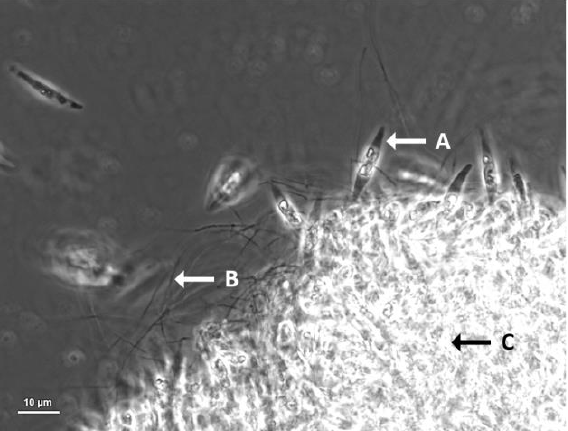
Figure 5. Saccharopolyspora sp. NFXS83 co-cultured with Phaeodactylum tricornutum CCAP 1055/1, 10 days after inoculation, under ×1000 amplification. (A) P. tricornutum free-living cell; (B) Hypha-like growth of Saccharopolyspora sp. NFXS83; (C) P. tricornutum biofilm with Saccharopolyspora sp. NFXS83.